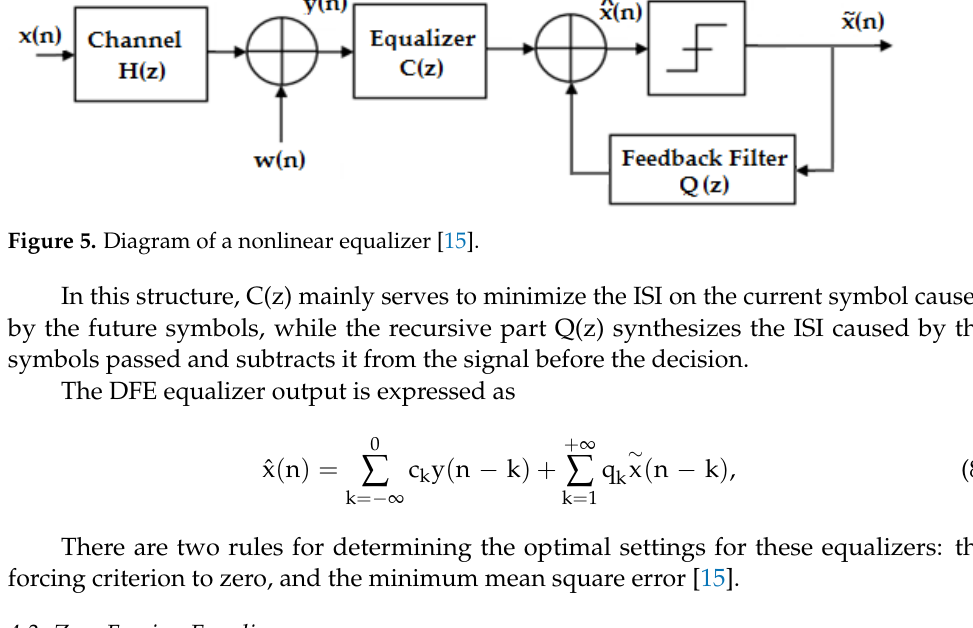
Figure 4. Diagram of a linear equalizer [15].